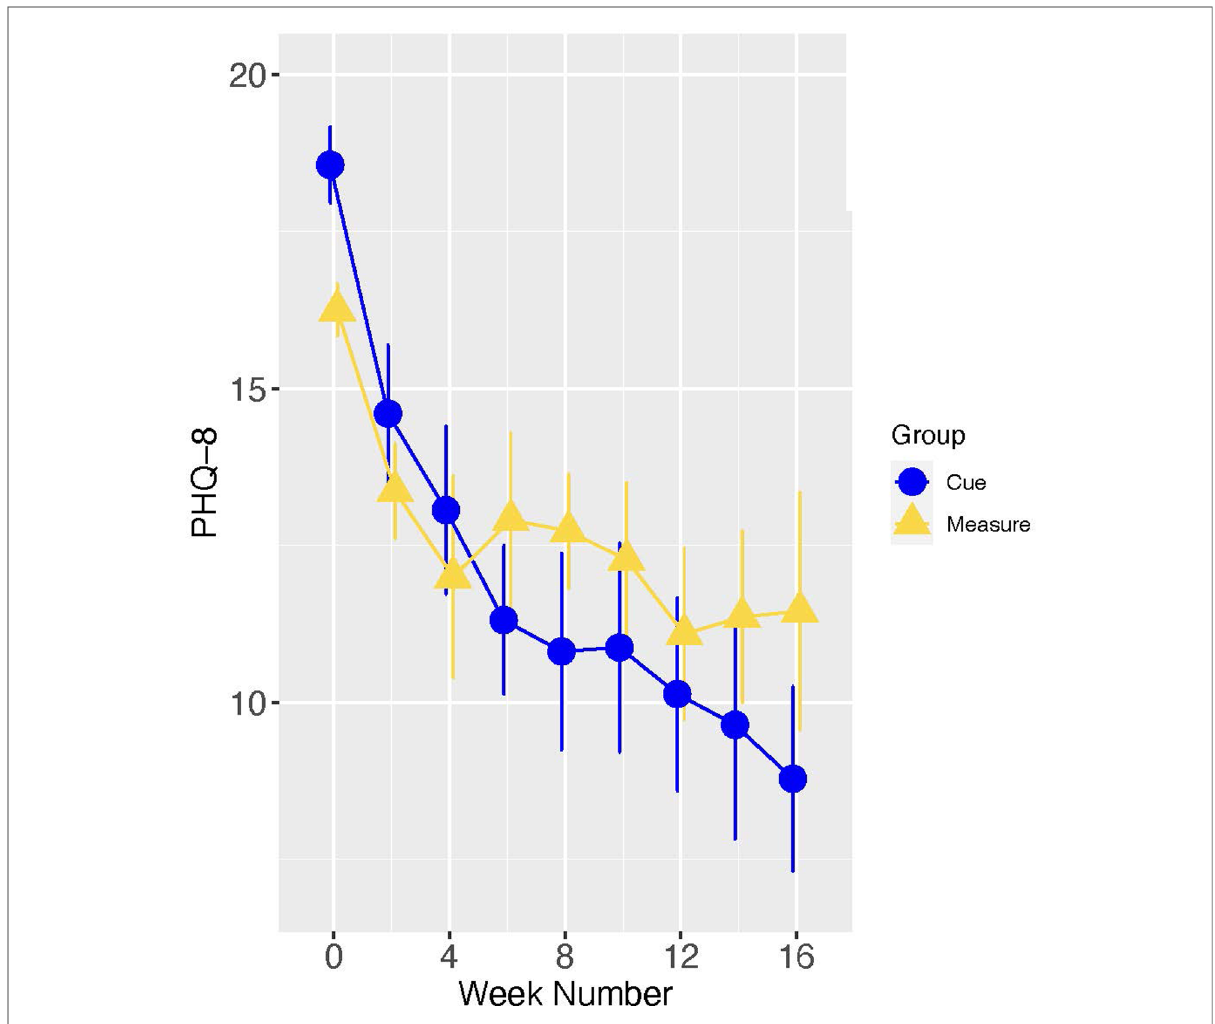
FIGURE 8 Means and standard errors of PHQ scores by study week – depressed-at-entry